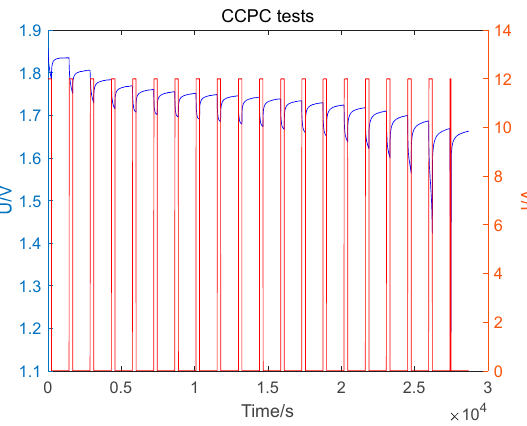
set between two discharging intervals to allow for the equilibrium. Certainly, when the terminal voltage drops to the lower cut-off value 1.2 V, the battery stack is treated as fully discharged. The specific pulse process is shown in Figure 3. The blue line represents the voltage, and the red line stands for the current. Figure 2. The composition of the experimental platform. Figure 2. The composition of the experimental platform.